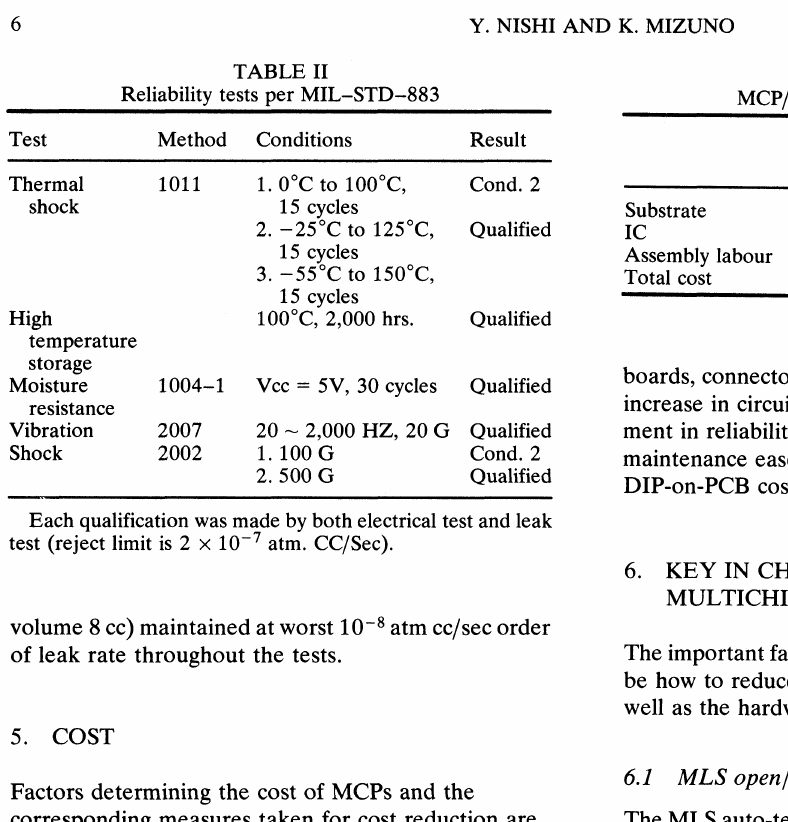
TABLE II Reliability tests per MIL-STD-883